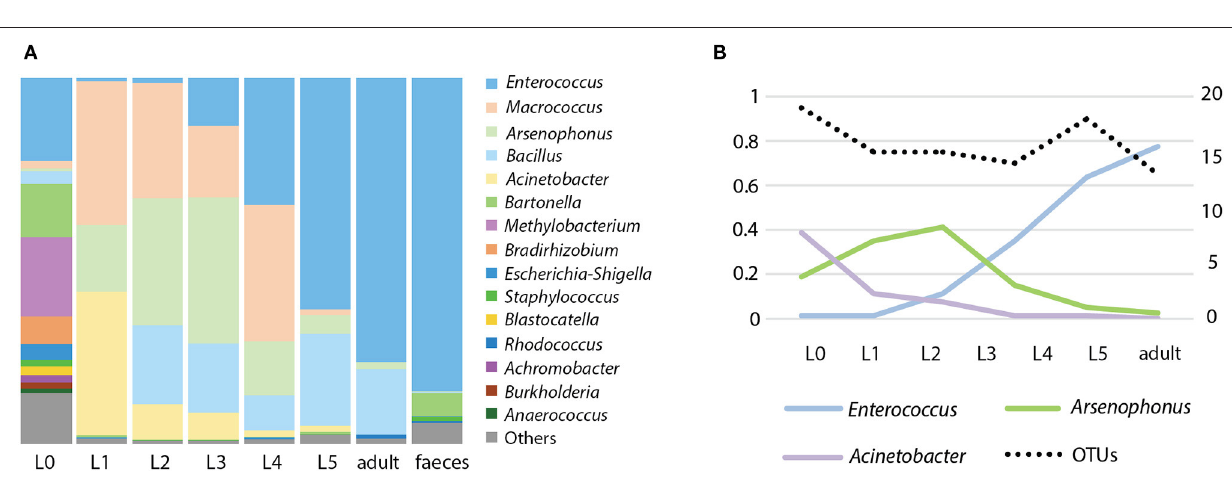
FIGURE 2 | Microbiome of R. prolixus along its ontogeny. (A) Relative abundance of the main genera in different developmental stages. L0 stands for eggs, L1-L5 are nymphal instars. (B) Variation of the dominant OTUs; percentage of the total reads number (left axis) and number of OTUs in individual stages (right